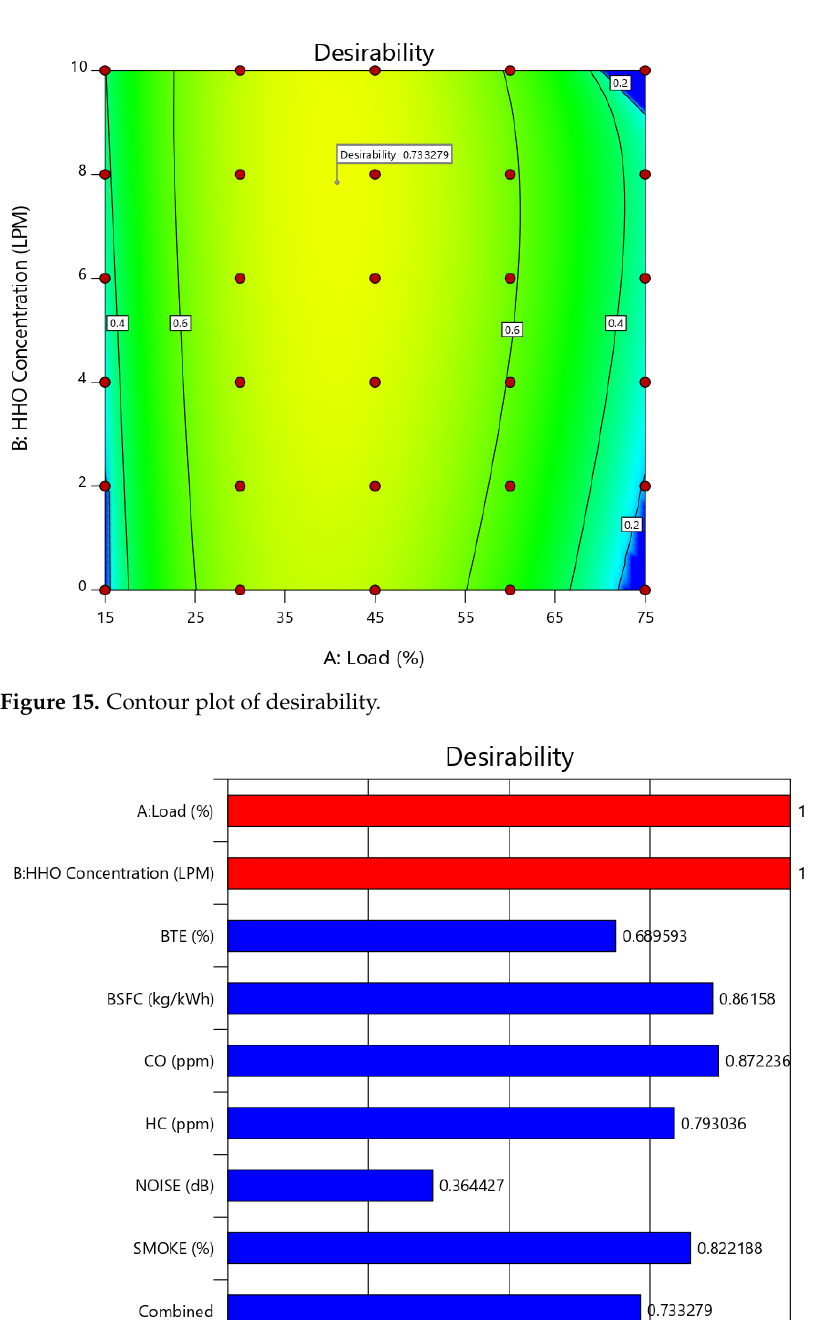
Table 16. Comparison of RSM and experimental